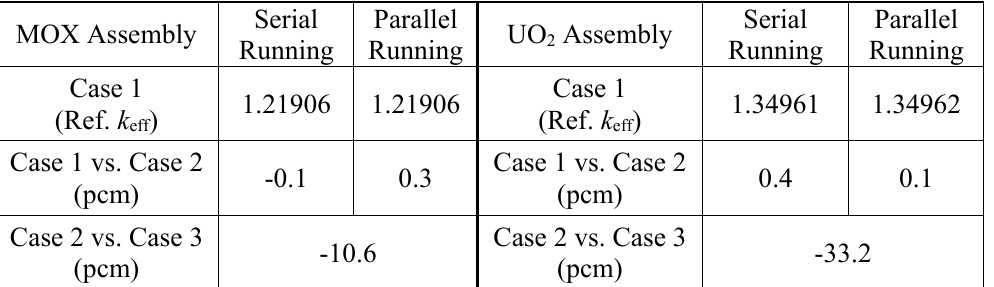
Table II. Verifications of MOCEX lattice